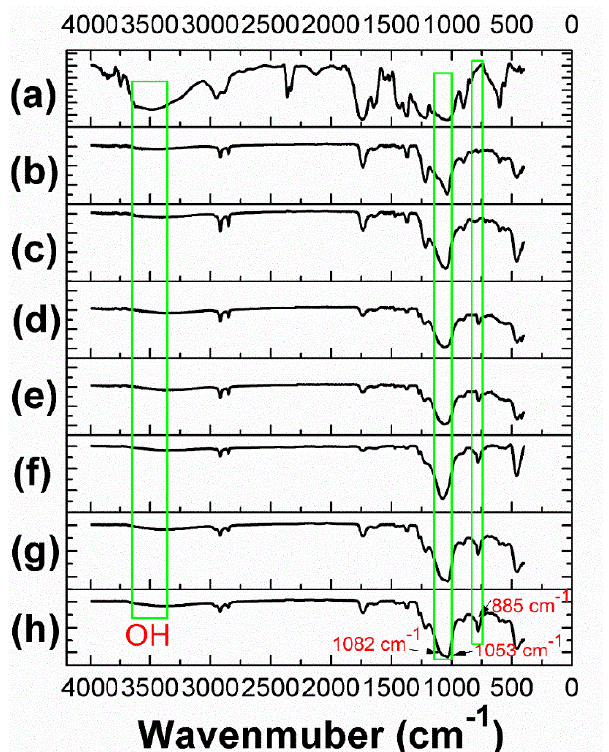
Figure 3. FTIR spectra of unmodified and modified CF: CF 0:0 ( a ), CF 1:0 ( b ), CF 4:1 ( c ), CF 3:2 ( d ), CF 1:1 ( e ), CF 2:3 ( f ), CF 1:4 ( g ), and CF 0:1 ( h ).